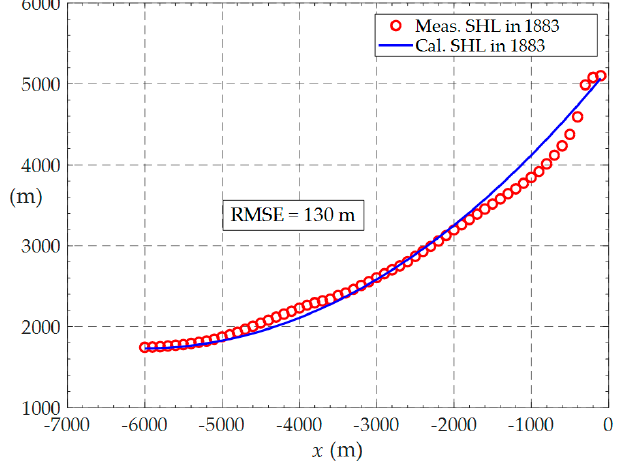
Figure 15. Best fit between calculated and measured shorelines in 1883 of the Ombrone River delta shorelines. Table 3. Calibrated values determined from the fitting process for the Ombrone River delta.